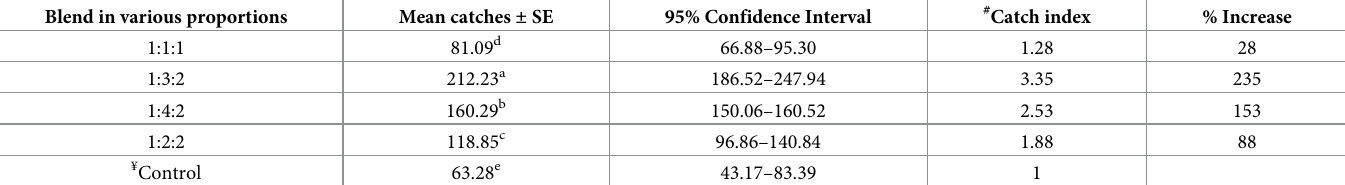
Table 3. Mean catches of G . pallidipes to NG2 G traps in the presence of blends of epsilon-nonalactone, nonanoic acid and 2-nonanone in varying proportions deliv- ered from 150micron sachets. Blend in various proportions Mean catches ± SE 95% Confidence Interval